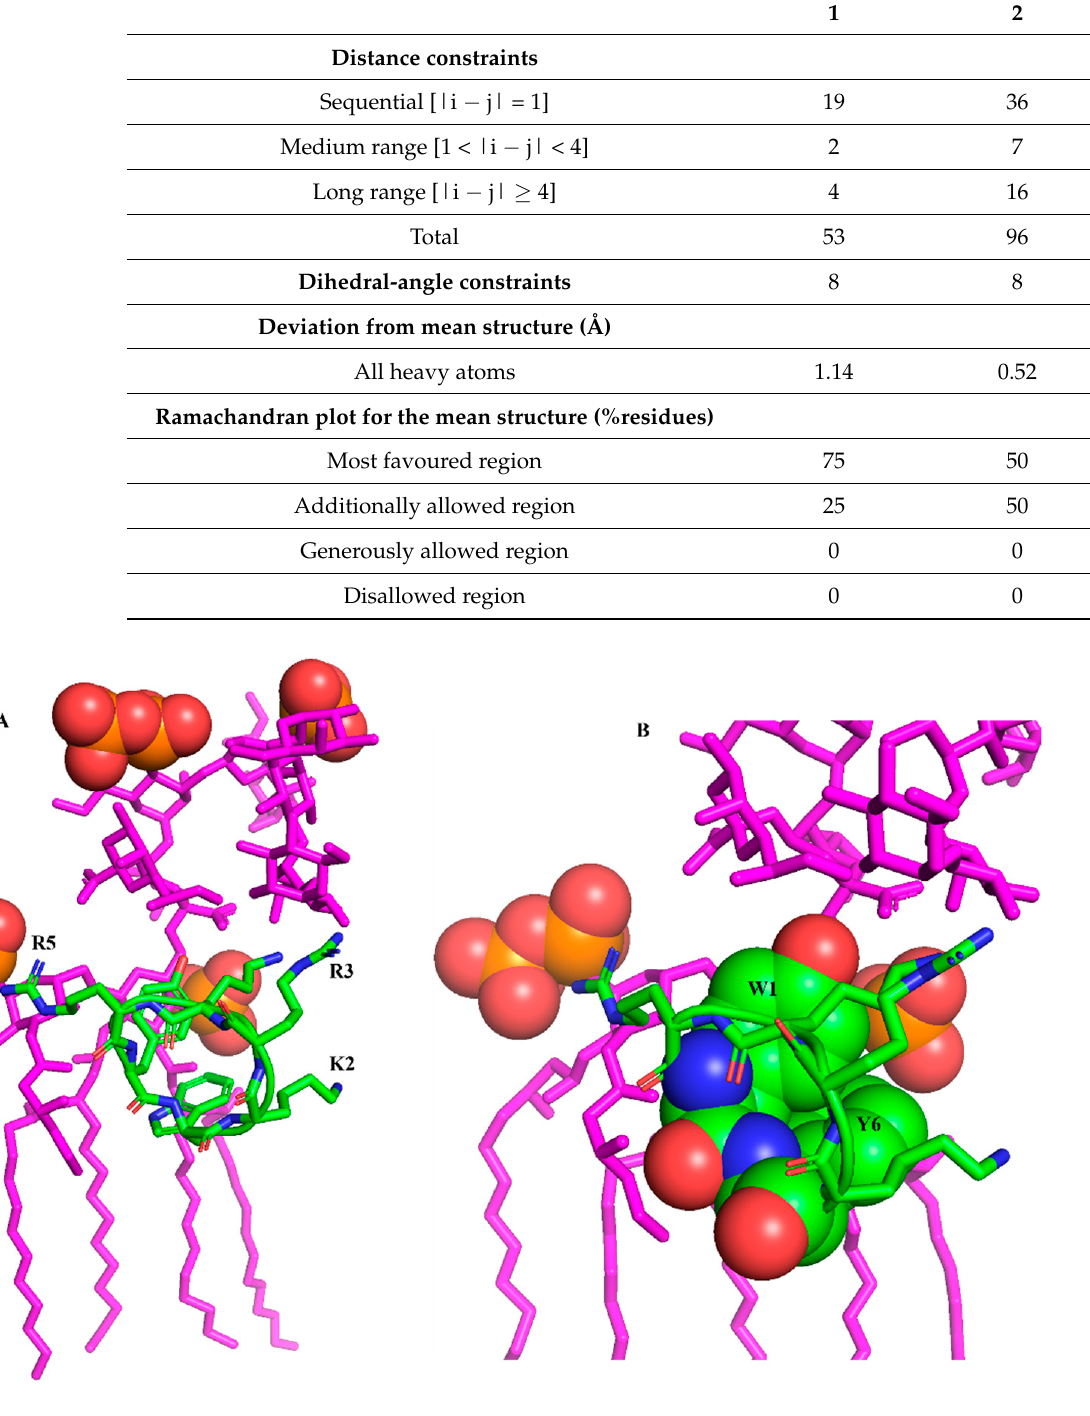
negatively charged phosphate groups (red, space filled) of lipid A of LPS. ( B ) An expanded view of the docked complex